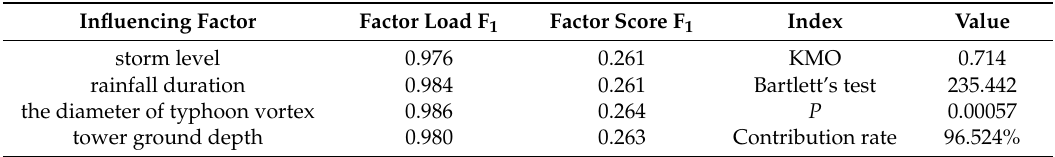
Table 2. Factor analysis of